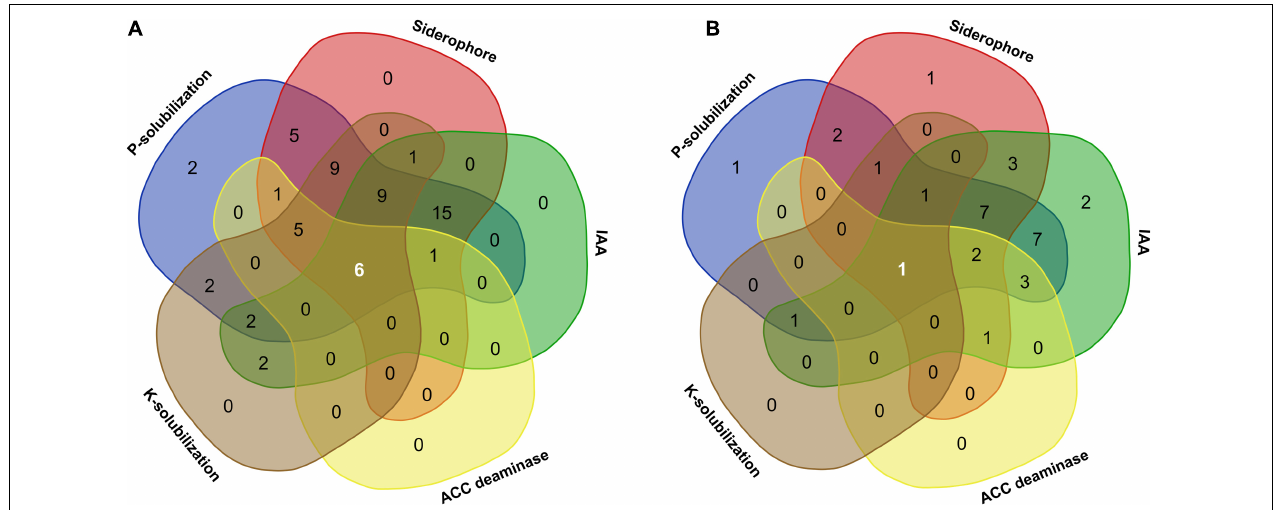
FIGURE 8 | Venn diagram illustrating the number of microbial communities associated with A. euchroma possessing unique and overlapping PGP traits. (A) Bacterial endophytes with common and unique PGP traits. Among 60 bacterial endophytes, 6 bacteria displayed all PGP characters, while 15 isolates showed 3 PGP characters (P-solubilization, siderophore, and IAA production). (B) Fungal endophytes with common and unique PGP traits. Out of 33 fungal endophytes, only one isolate shared all PGP traits, while seven isolates showed three PGP characters (P-solubilization, siderophore, and IAA